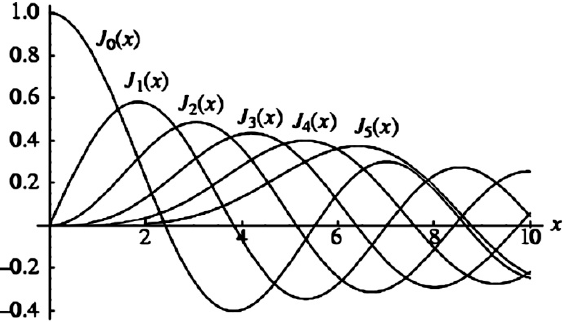
Figure 2. Image of the Bessel function of the first kind.